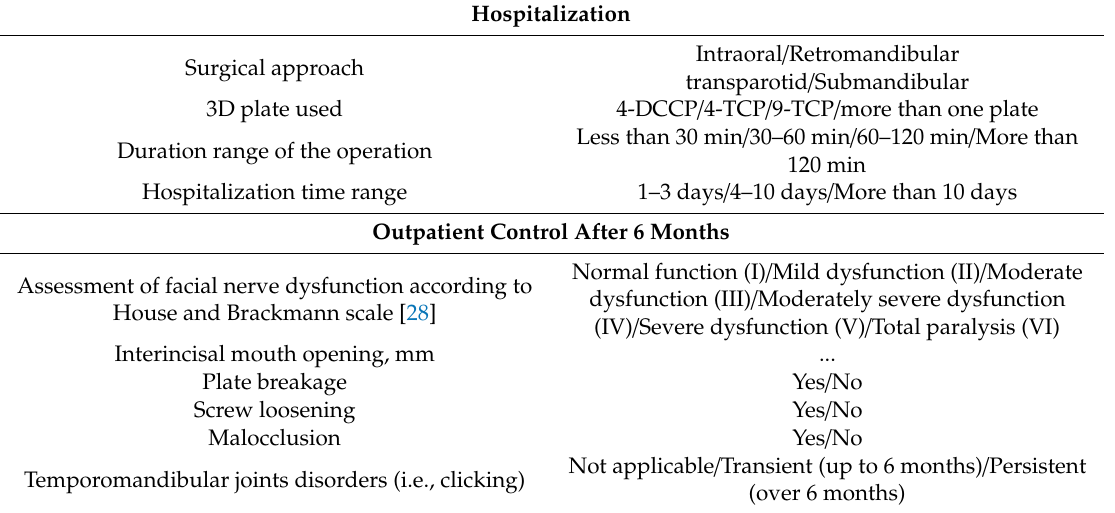
Table 5. Observation form.